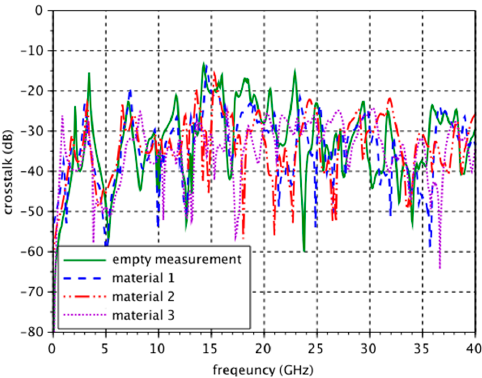
Figure 25. Crosstalk measured with planar BGA contact pad assembly of Figure 23 without an ACP specimen inserted and with three different ACP specimens.